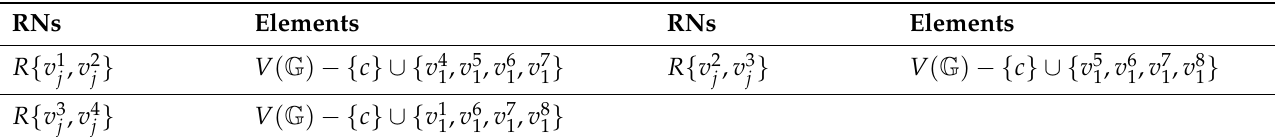
Table 12. RNs ´ R u for 21 ≤ u ≤ 32 and 2 ≤ j ≤ 4.